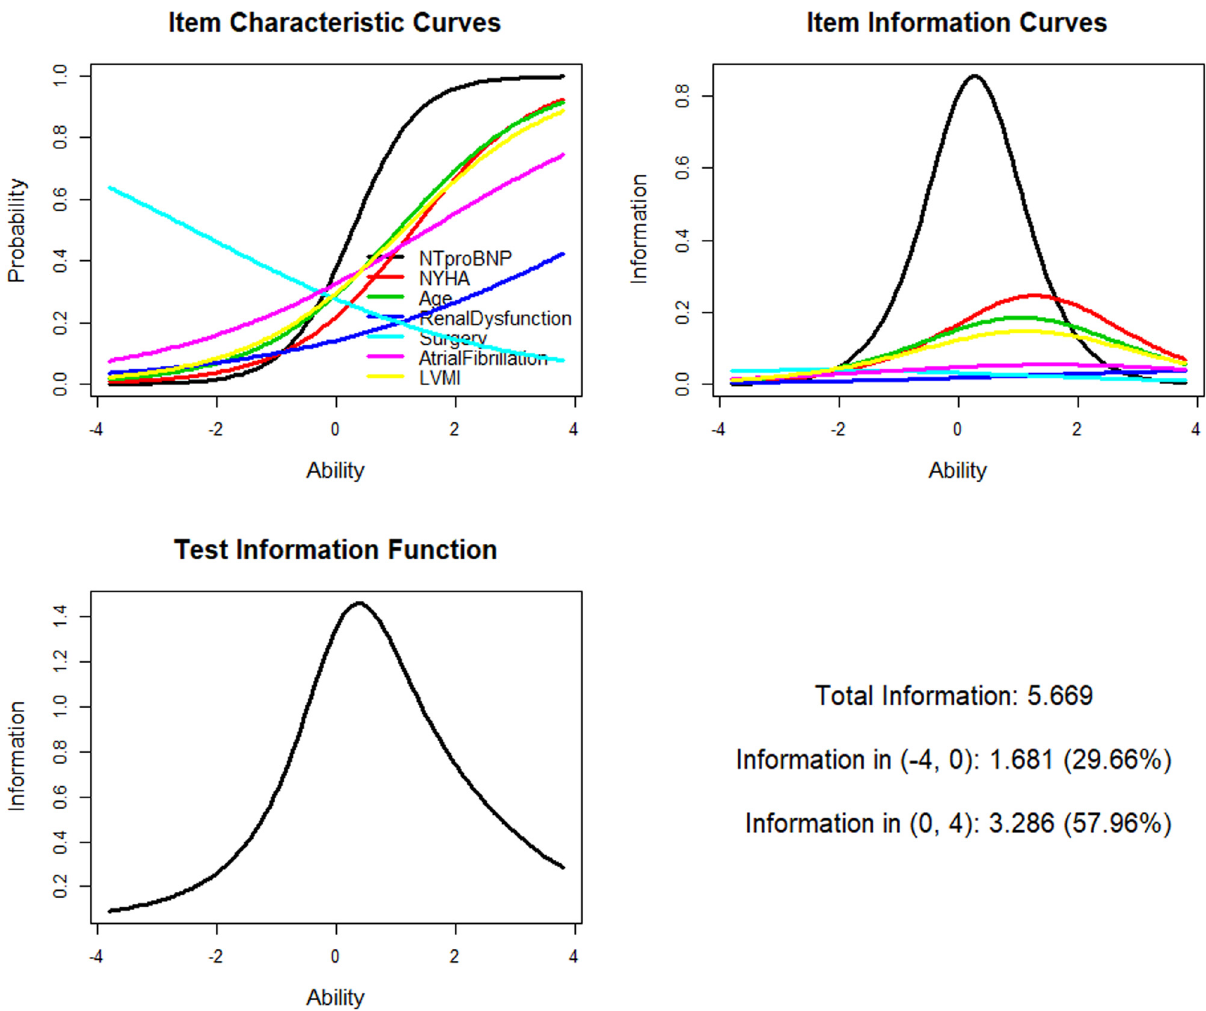
Figure 2: LTA curve. Abbreviations: LTA, latent trait analysis; LVMI, left ventricular mass index; NT - proBNP, N - terminal pro - B - type natriuretic peptide; NYHA, New York Heart Association.